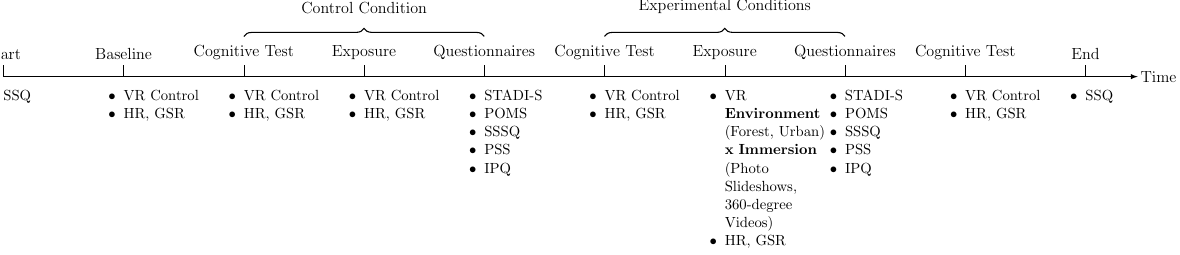
Figure 12. Experimental procedure. VR virtual reality (i.e., the contents were displayed using a head-mounted display), Control a silent black virtual room with a white screen in the middle showing a fixation cross, SSQ Simulator Sickness Questionnaire, HR Heart Rate, GSR Galvanic Skin Response or Skin Conductance Response (SCR), STADI‑S State Trait Anxiety Depression Inventory-State, POMS Profiles of Mood States, SSSQ Short Stress State Questionnaire, PSS Perceived Stress Scale, IPQ Igroup Presence